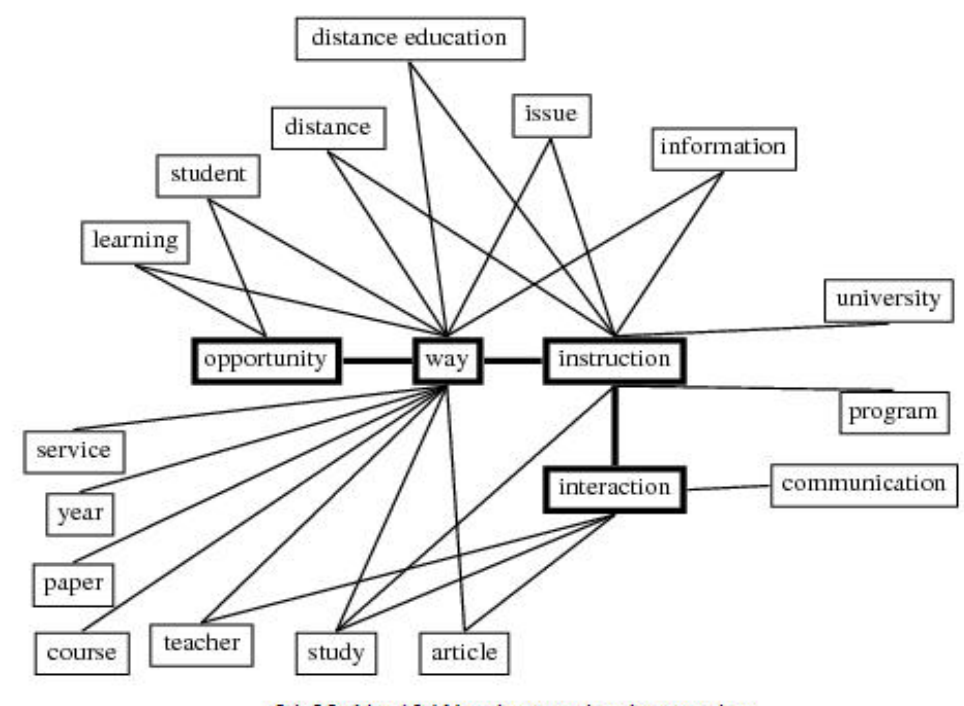
Figure 2. 94-99-Abs11-Way-Instruction-Interaction lexical map. In the subsequent time period, the lexical map 00-05-Abs3-Interaction-Communication-Tool shows that the connection between interaction and communication strengthens (see Figure 3), where both communication and interaction are pass-1 terms. The 2000 to 2005 time period shows that interaction also interacts with other relevant terms: strategy , learning environment , and tool . In this time period, interaction appears to have escalated as a key term in distance education research literature and has clearly evolved between time